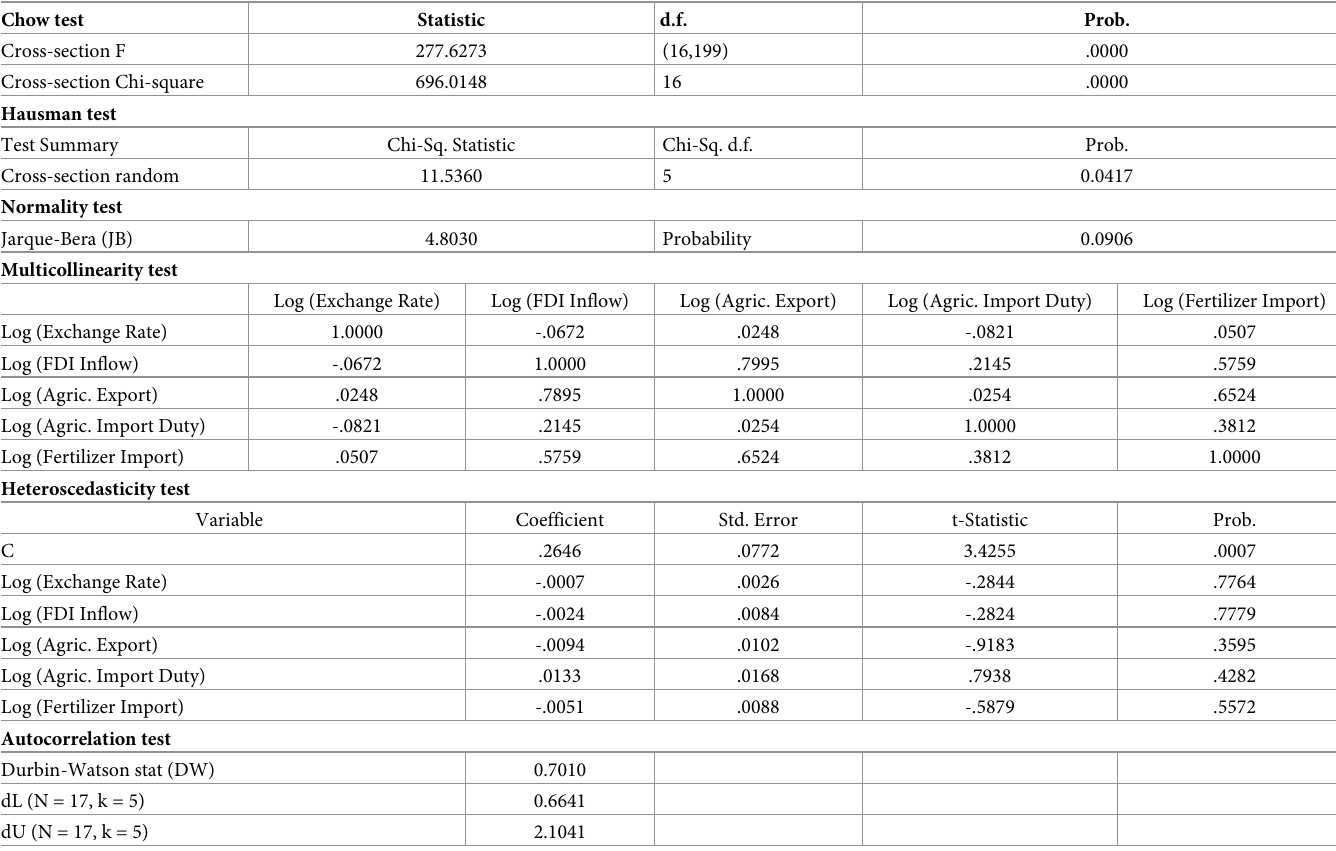
Table 2. The results of Chow, Hausman, normality, multicollinearity, heteroscedasticity, and autocorrelation test.